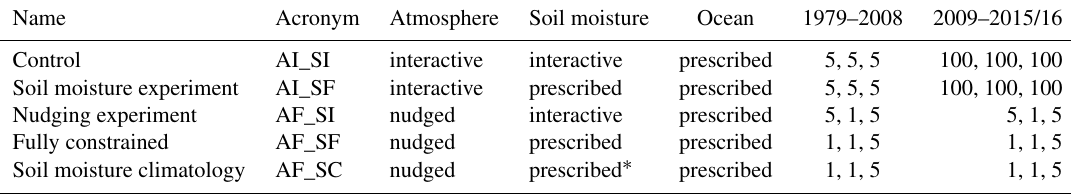
Table 1. Overview of experiments and configuration of the model components. The number of simulation runs for the experiments is given for the two successive simulation periods (1979–2008 and 2009–2015/16) and for the models in this order: CESM1.2, EC-Earth3,